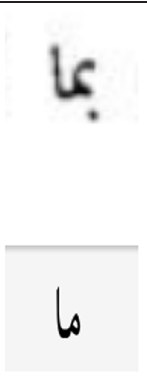
Figure 9: Example of problematic ligature and error in transcription.